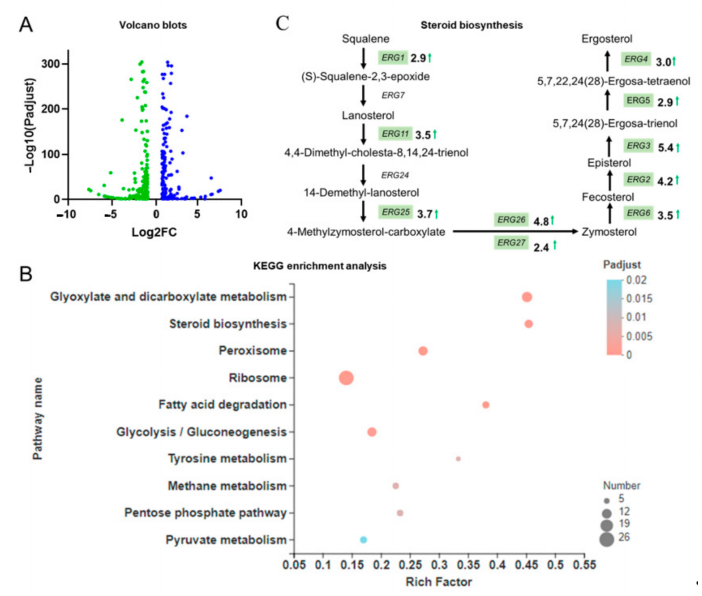
Figure 2. The analysis of differentially expressed genes (DEGs). ( A ) Volcano blots to show significant DEGs. Dispersion graph of the − log10(P adjusted) ( y -axis) against the log2(FC) ( x -axis). Green dots and blue dots represent genes that were significantly downregulated and upregulated, respectively, in YPM media for 24 h. ( B ) KEGG pathway enrichment of upregulated genes in the YPM media for 24 h; ( C ) The expression pattern of genes in the steroid biosynthesis pathway in the YPM media; green arrows represented up-regulation and bolded numbers represented the fold of